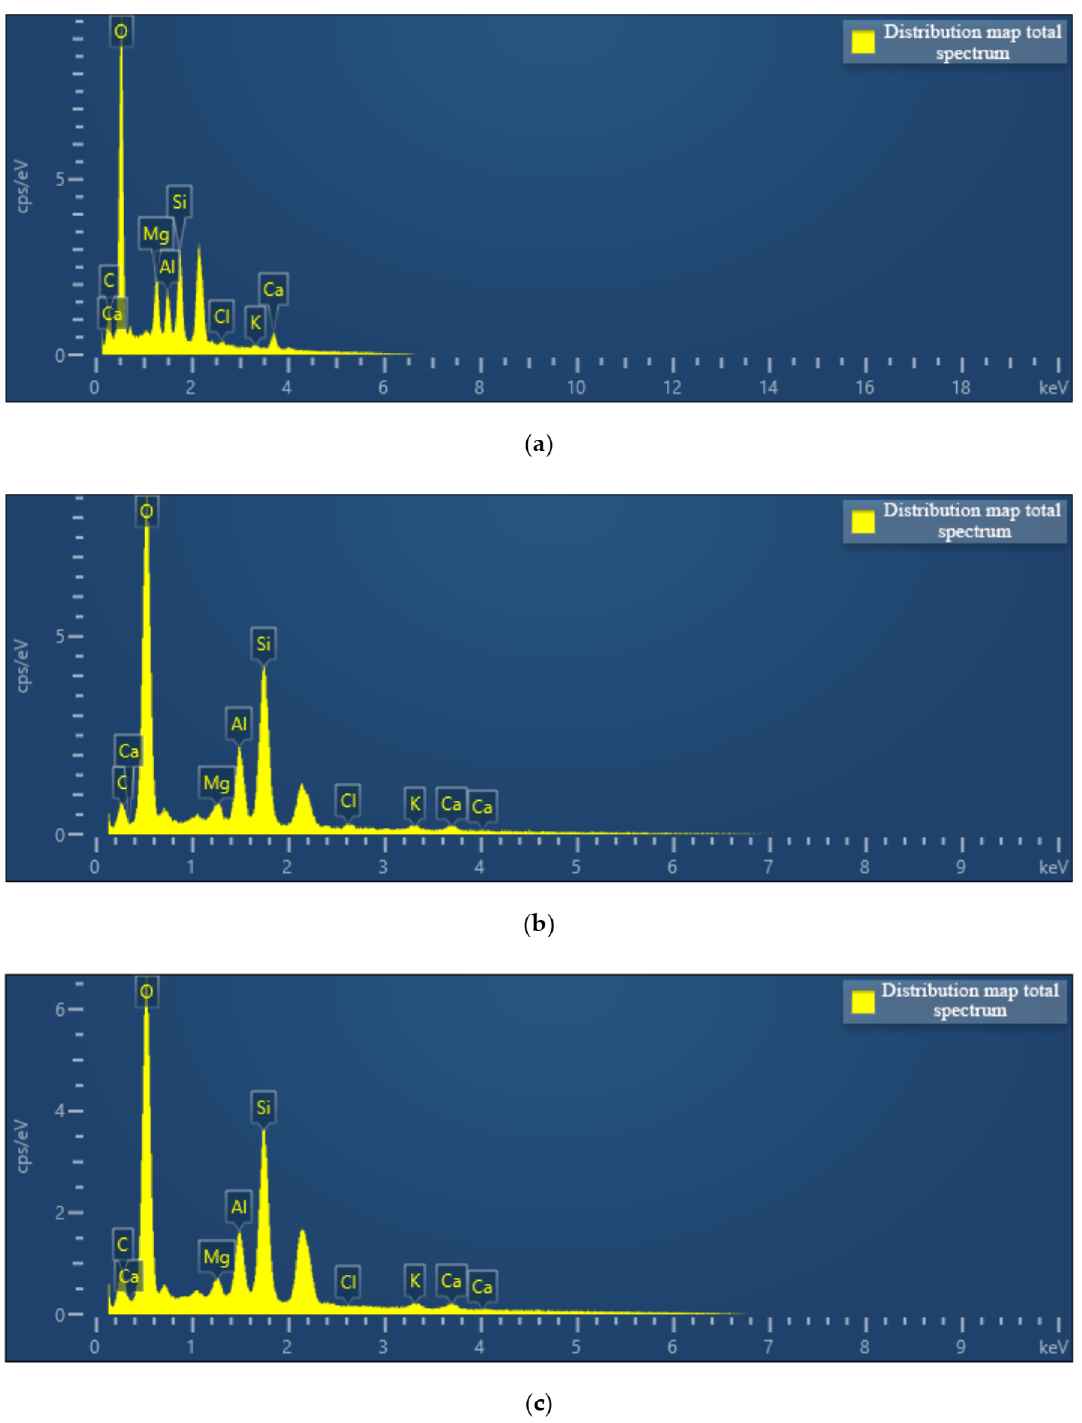
Figure 13. Element distribution of different soil–rock mixture columns. ( a ) D1; ( b ) B3; ( c ) Blank control